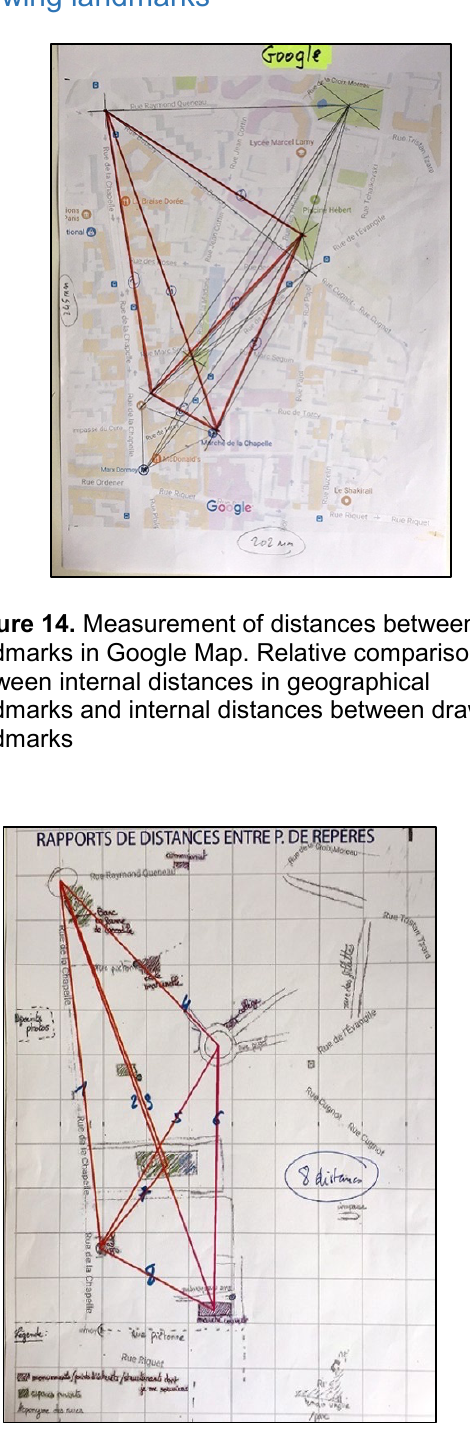
Figure 15. Example of measurement of distances between the same 6 landmarks in the sketch maps